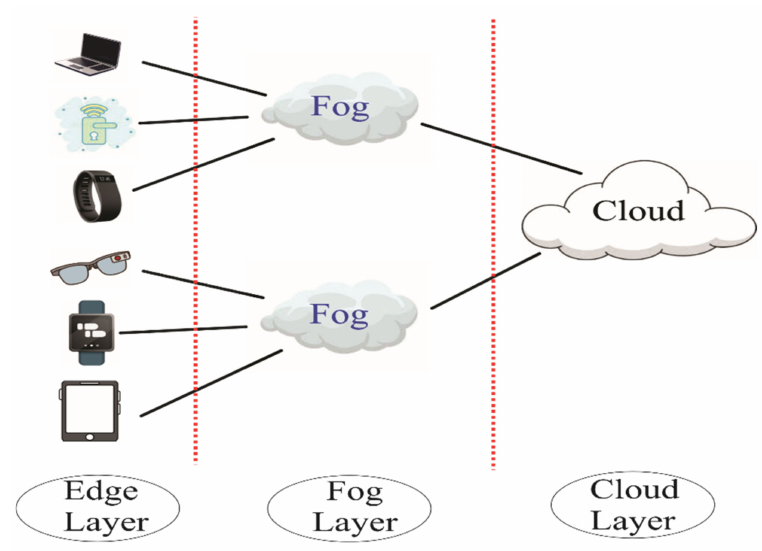
Figure 1. Structure of IoT ecosystem assisted by